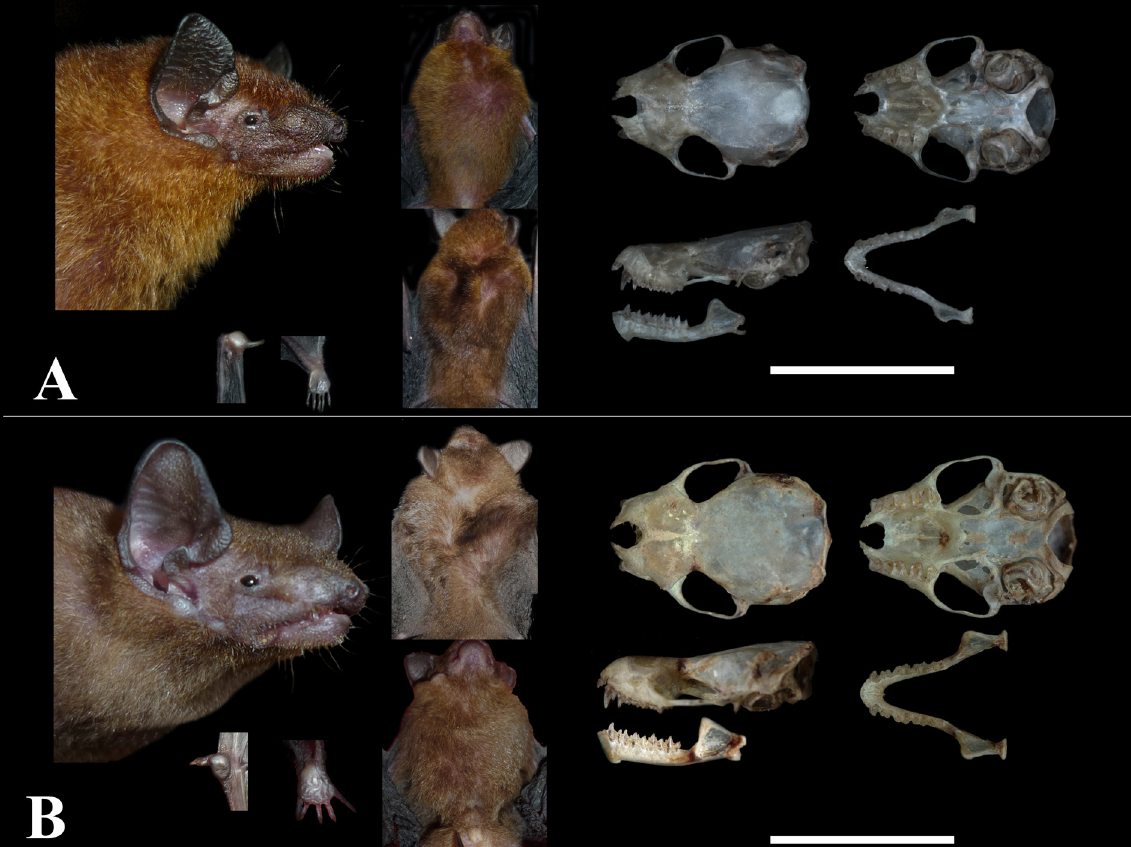
Fig. 5. Morphological characteristics of the two nominal species of the genus Tylonycteris Peters, 1872. A . T. pachypus (Temminck, 1840) (corrected taxon name is T. fulvida (Blyth, 1859)), IEBR-VN11- 0015. B . T. robustula Thomas, 1915 (corrected taxon name is T. tonkinensis Tu, Csorba, Ruedi